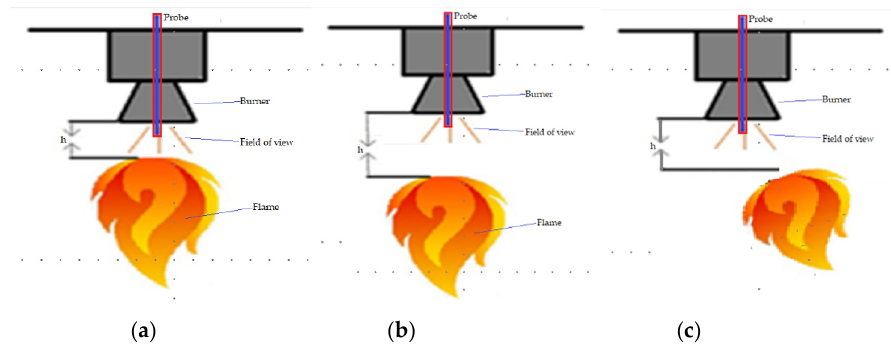
Figure 11. Some conditions out of standard for the flame. ( a ): well developed at a distance h; ( b ): h too far from the burner; ( c ): h too far and non-symmetric flame.